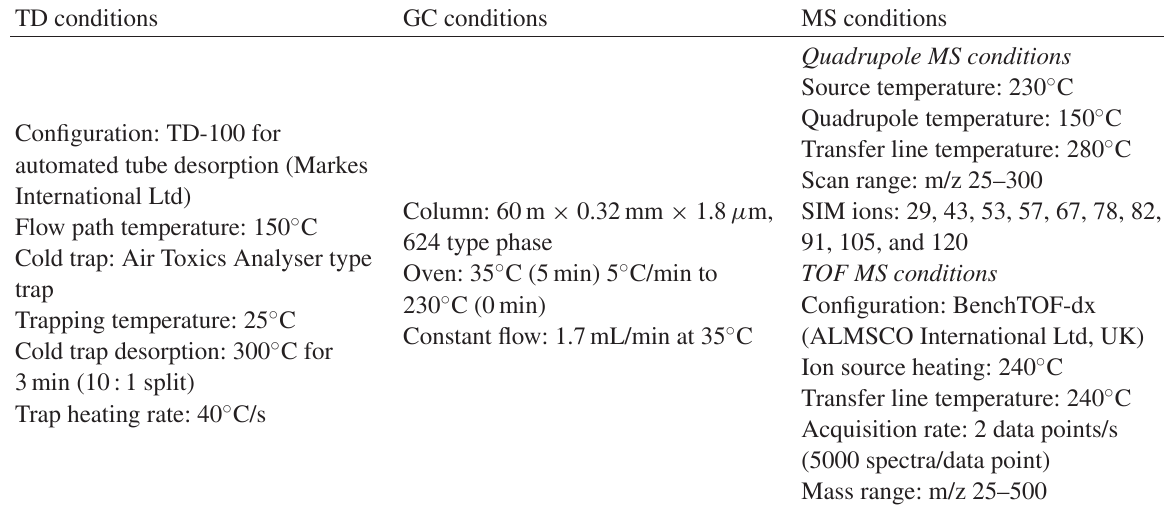
TABLE 10: Sampling and analytical